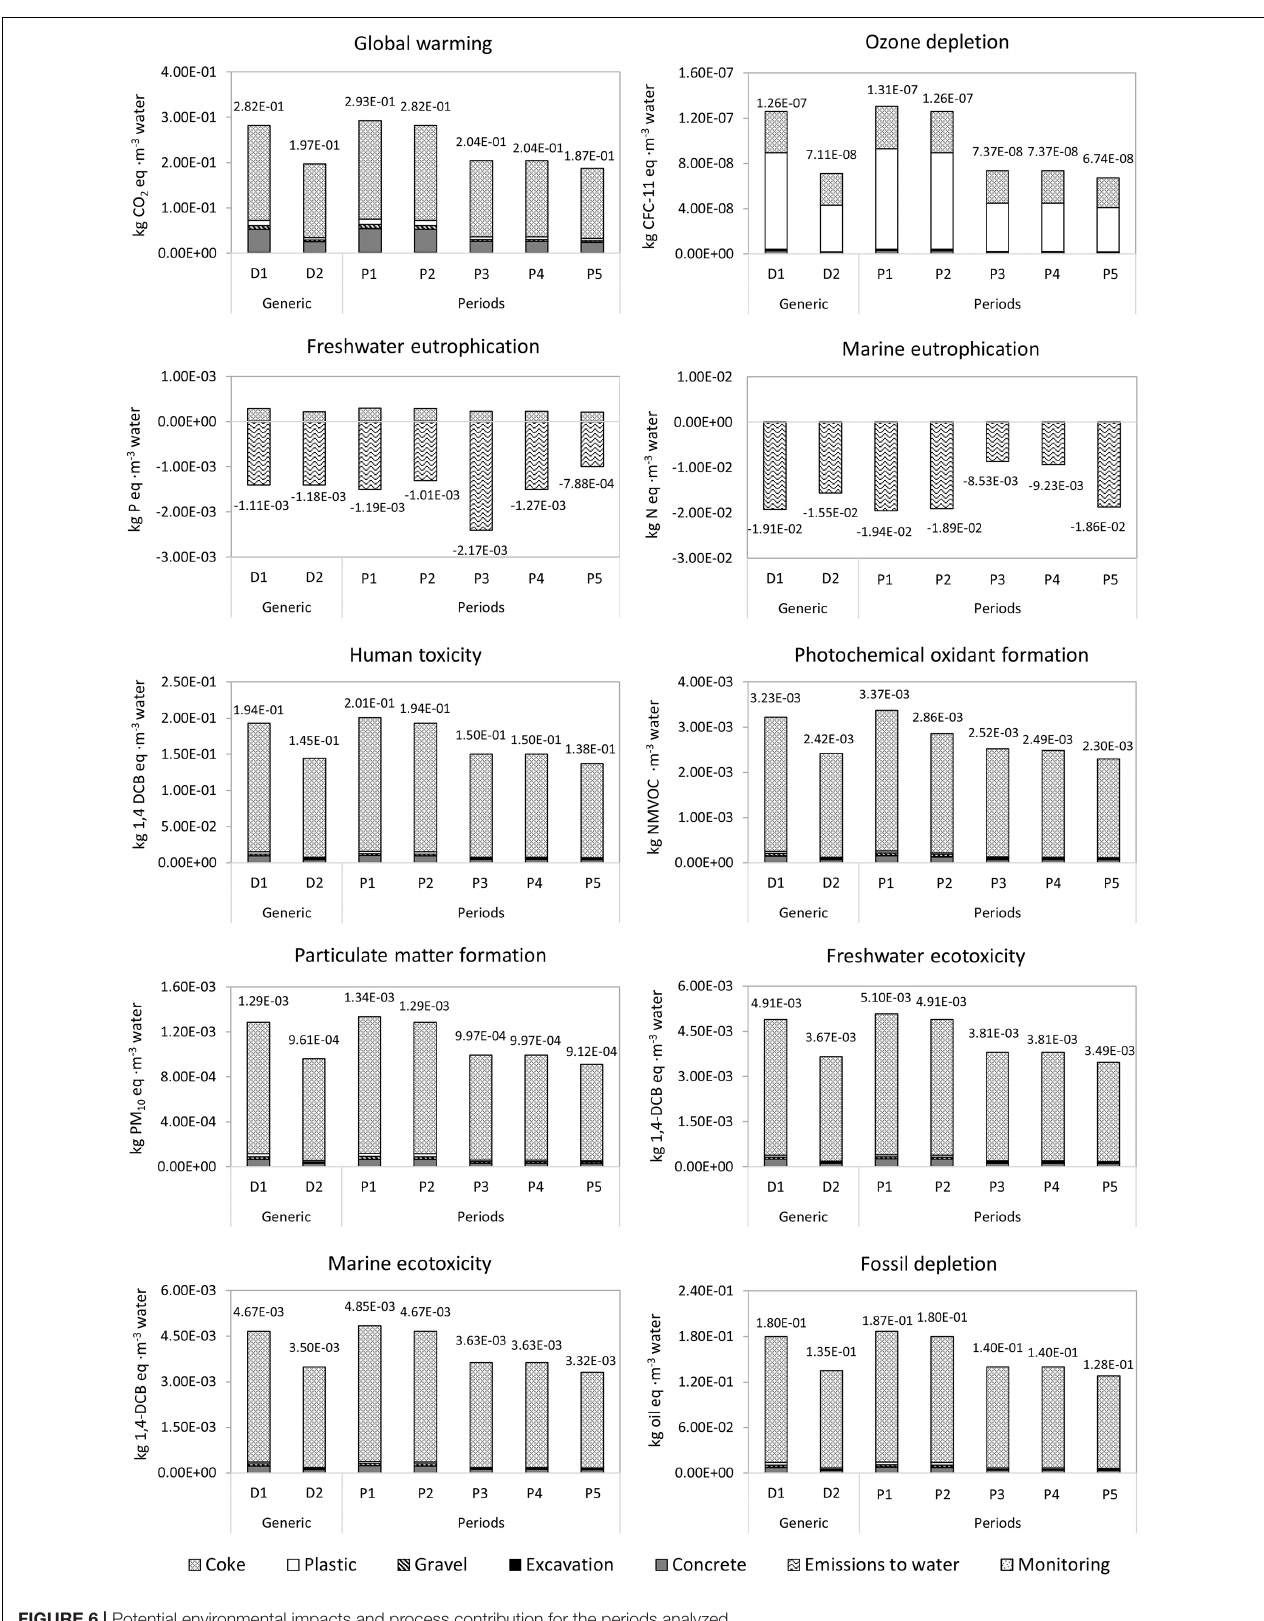
FIGURE 6 | Potential environmental impacts and process contribution for the periods analyzed.